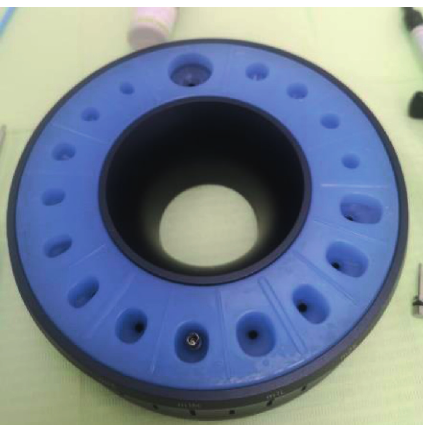
Figure 4: Placement of the prefabricated abutment into the Cervico device.